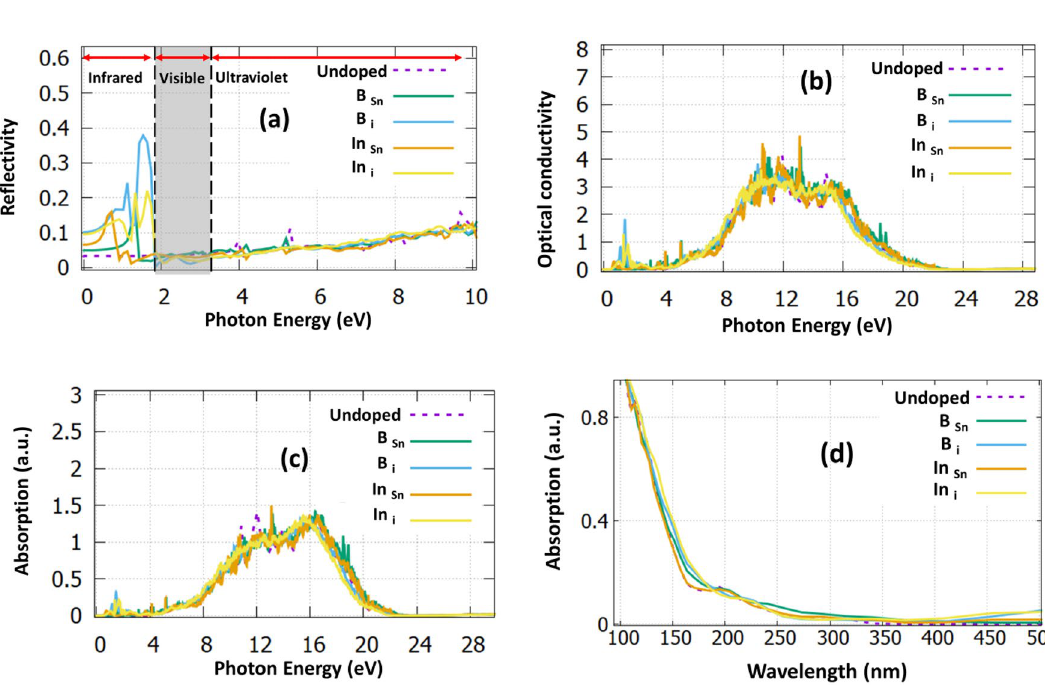
Figure 5. ( a ) The reflectivity for all the doped structures ( b ) The optical conductivity for all the studied structures ( c ) the absorption coefficient for all the structures versus the photon energy ( d ) the absorption coefficient for all the structures versus the wavelength. The dotted purple and dotted green, correspond to the undoped SnO 2